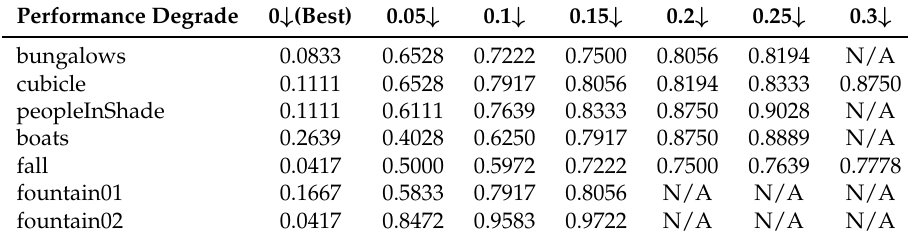
Table 5. Ratio of removed filters (%). These ratios are calculated when the best F-measure value is marked, or a filter is removed at last in each iteration. N/A occurs when all candidates of removed filters cause performance degradation with more than a threshold